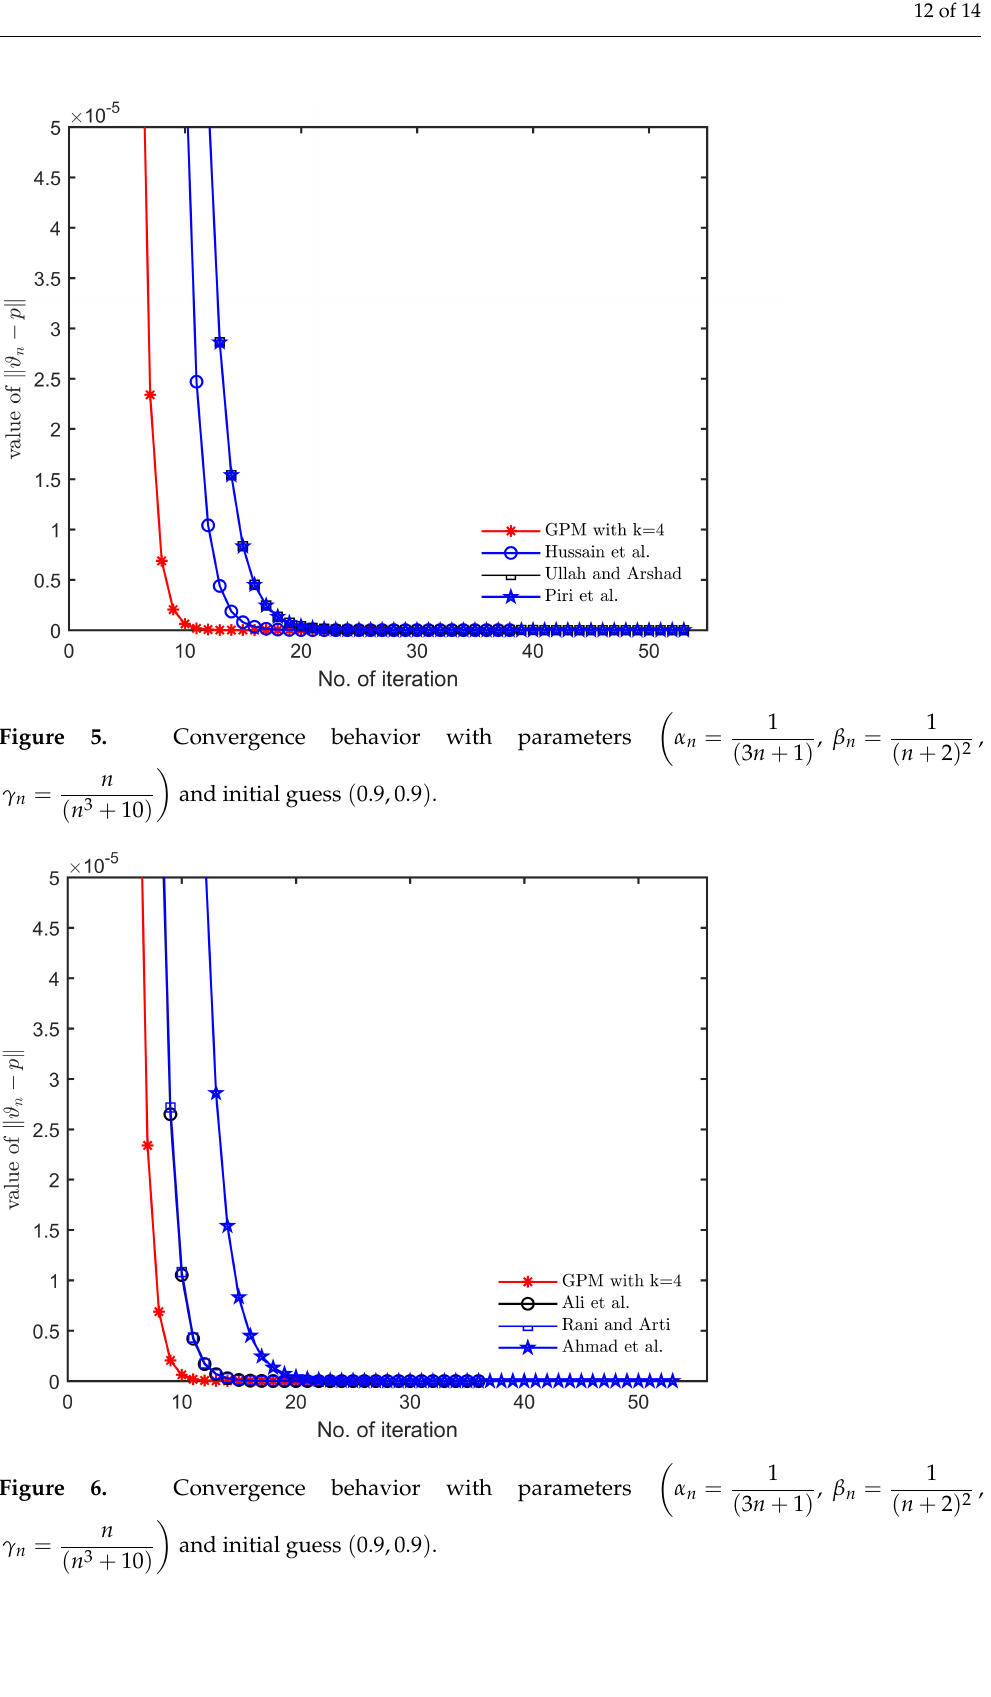
(cid:18) 1 1 α n = , β n = , ( 3 n + 1 ) ( n + 2 ) 2